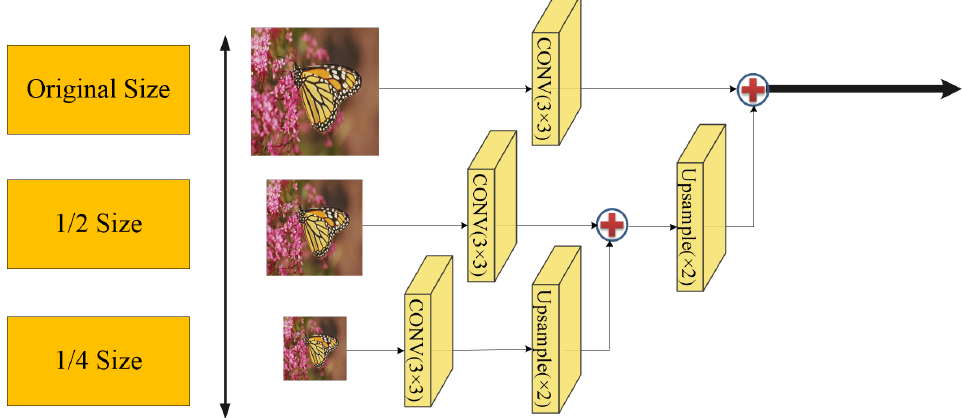
Figure 4. The Laplacian pyramid framework for our pre-trained module, which contains three convolutional layers with 3 × 3 filter kernels, and two up-sampled operators by a factor of 2. As shown in Table 1, we design different multipath inputs as contrast